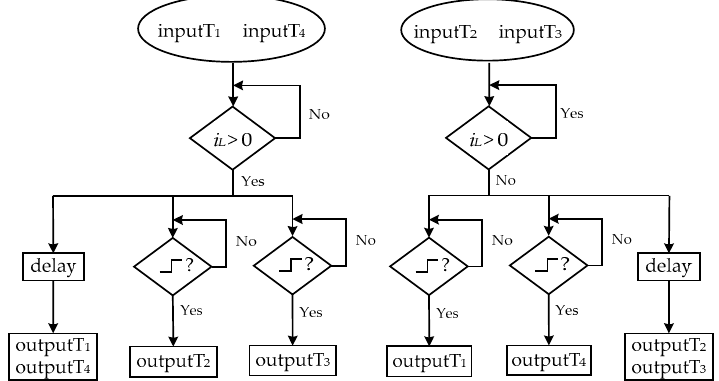
Figure 8. Logic diagram of the desaturation pulse control of the PWM converter with RC-IGBT.